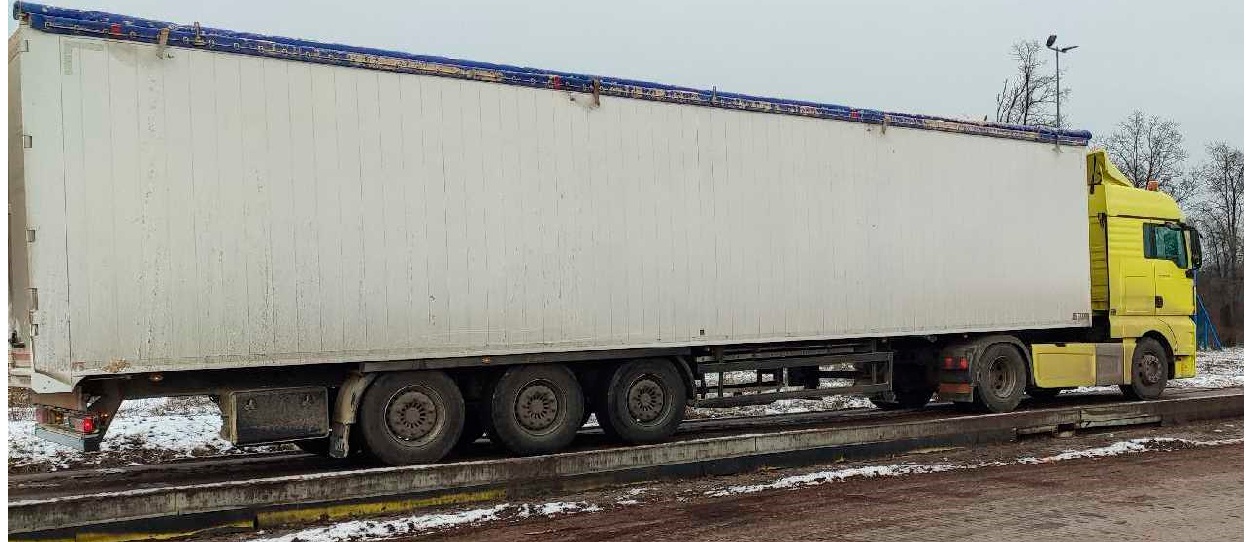
Figure 2. A station for weighing whole trucks set on a stationary scale.